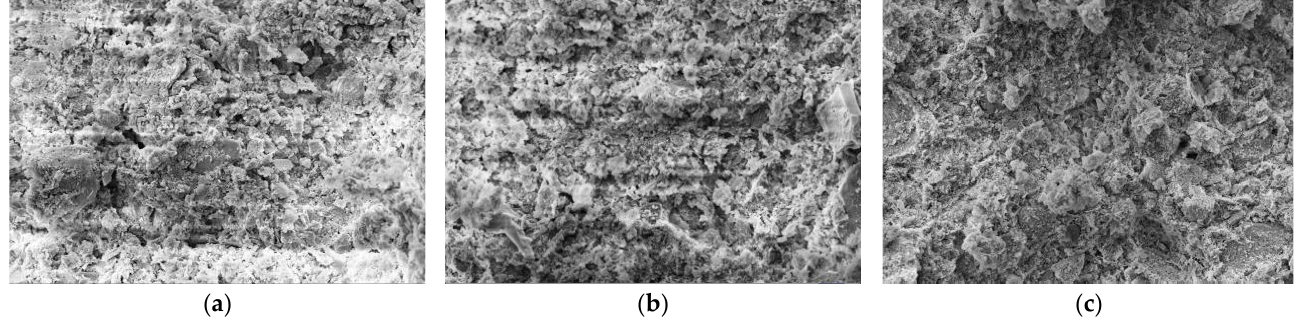
Figure 8. SEM images at different curing temperatures (at a magnification of 2K): ( a ) T = 18 °C ; ( b ) T = 36 °C ; ( c ) T = 46 °C .